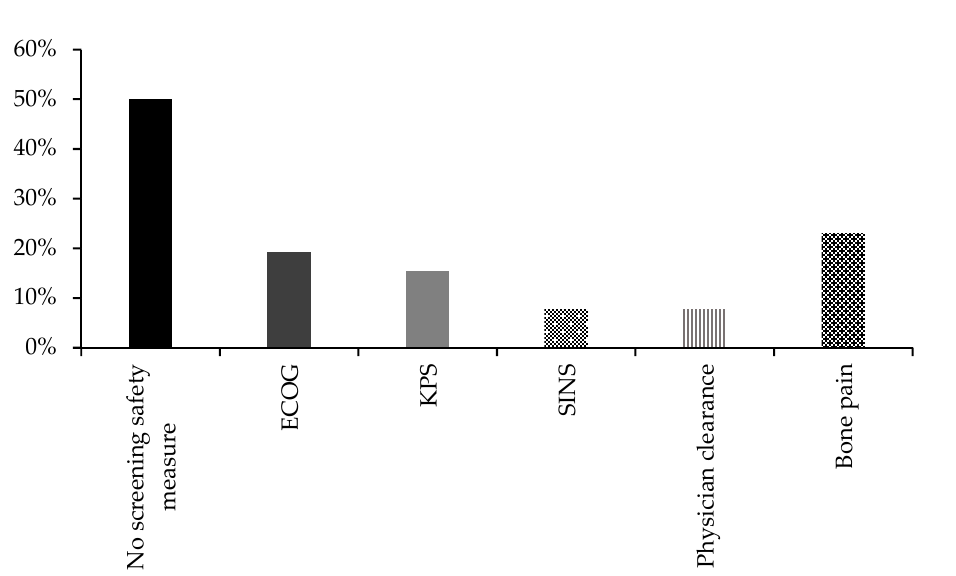
Figure 3. Safety screening in the included trials, presented as percentage. Abbreviations: ECOG, Eastern Cooperative Oncology Group; KPS, Karnofsky Performance Status; SINS, Spinal Instability Neoplastic Score.